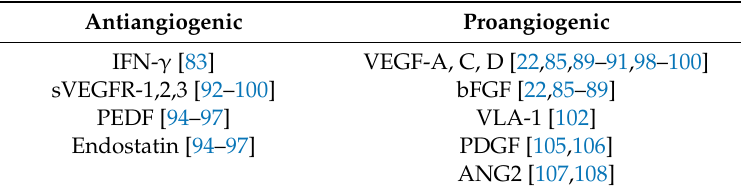
Table 3. Markers of angiogenesis and